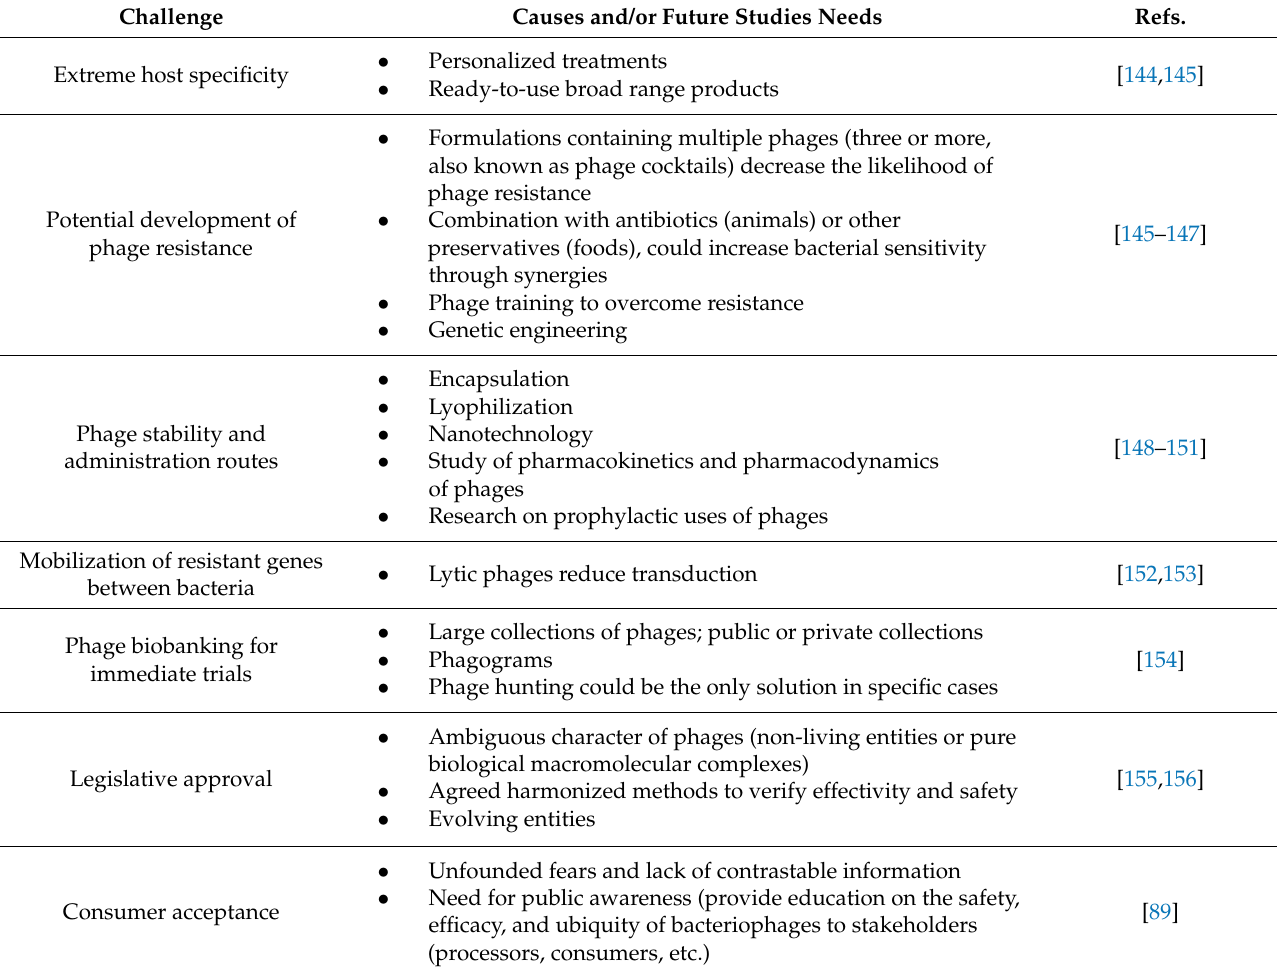
Table 4. Challenges and possible responses to resolve specific issues with using phages. Challenge Causes and/or Future Studies Needs